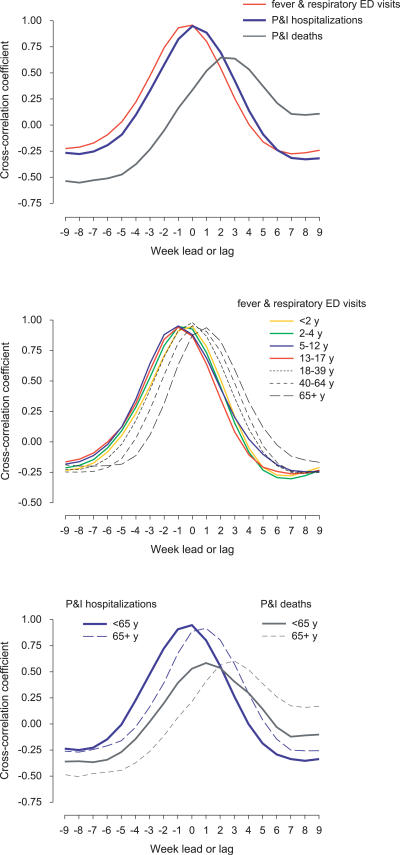
Epidemic Weekly Lead or Lag Cross-Correlation during the 2003–2004 Influenza A/Fujian Season in New York CityExcess fever and respiratory ED visits and P&I hospitalizations and deaths were correlated against influenza isolates during the 33 wk centered on peak isolates. Top, maximum cross-correlation values for ED visits and hospitalizations coincided with influenza isolates (no lag) with ED visits leading hospitalizations, by less than 1 wk. Maximum correlation values for P&I deaths lagged isolates by 2 wk. Middle, maximum correlation values for 2–4 y, 5–12 y, and 13–17 y ED visits led isolates by 1 wk, < 2 y, 18–39 y, and 40–64 y visits had no lag, and ≥ 65 y visits lagged isolates by 1 wk. Bottom, maximum cross-correlation values for < 65 y P&I hospitalizations had no lag, for ≥ 65 y hospitalizations and < 65 y P&I deaths had a 1 wk lag, and for ≥ 65 y P&I deaths had a 3 wk lag.